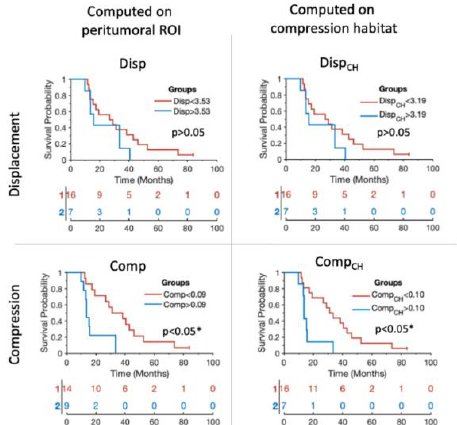
Figure 4. Kaplan–Meier plots showing the stratification capability of the median biomarkers proposed for each of the patients included in the study. Blue lines represent the patients showing higher tumor mass effect according to each of the biomarkers. Red lines represent the patients showing lower tumor mass effect according to each of the biomarkers. The x axes represent the overall survival in months. * Indicates significant difference ( p <